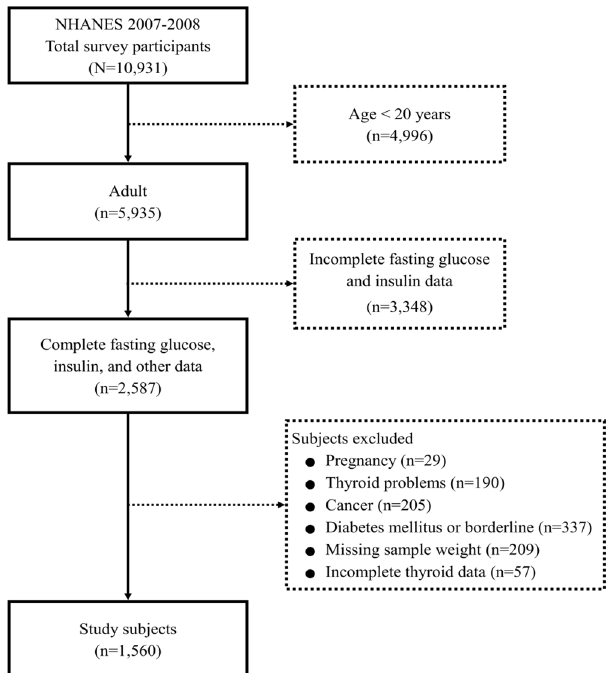
Figure 1. Flow diagram of subject